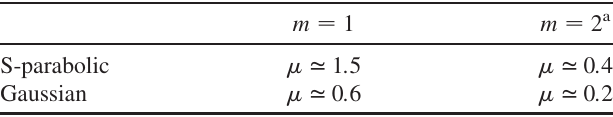
TABLE II. Estimated instability thresholds.